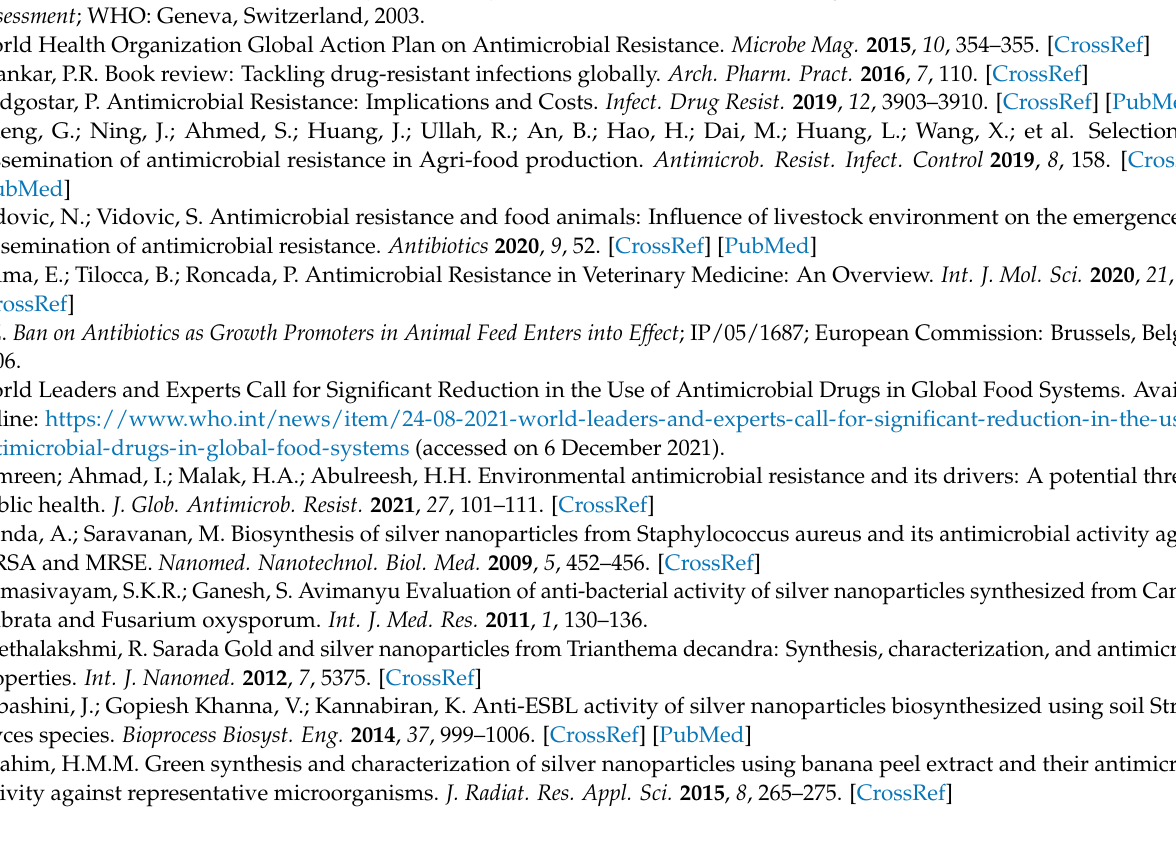
(F1-F5); Table S3. Results of the relative organ weight for each animal of the dose-finding study (F1-F5); Table S4. Results of the hematological parameters for each animal of the dose-finding study (F1-F5); Table S5. Results of the biochemical evaluation for each animal of the dose-finding study (F1-F5); Figure S2. Results of the body weight growth from males (a) and females (b) of the 28-day oral toxicity study; Table S6. Results of the hematological evaluation of the repeated-dose 28-day study; Table S7. Results of the absolute and differential count of the repeated-dose 28-day study; Table S8. Results of the biochemical analysis of the repeated-dose 28-day study; Table S9. Results from the coagulation analysis of the repeated-dose 28-day